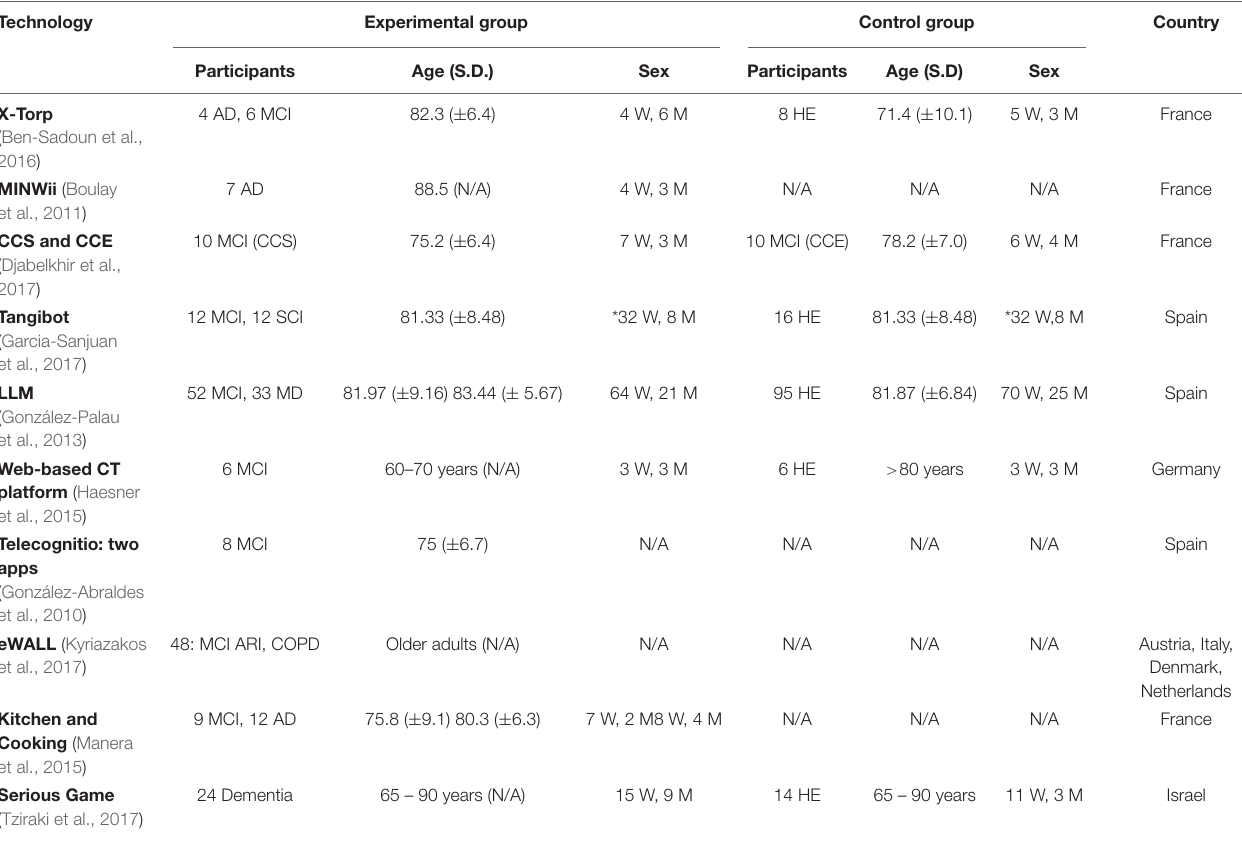
TABLE 2 | Participant’s sociodemographic characteristics. Technology Experimental group Control group Country Participants Age (S.D.) Sex Participants Age